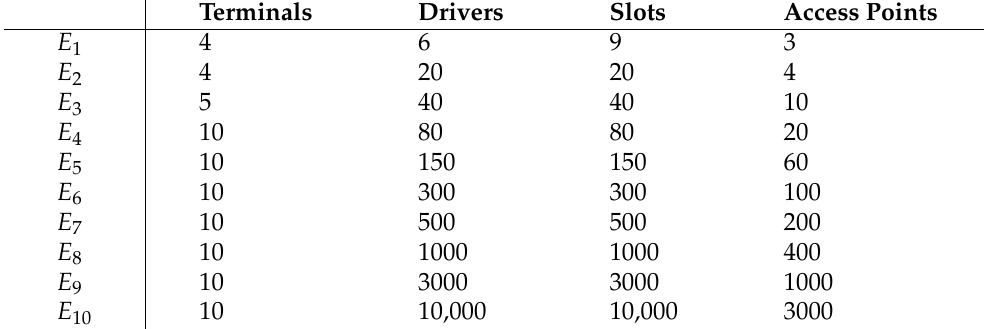
Table 8. Experimental data.